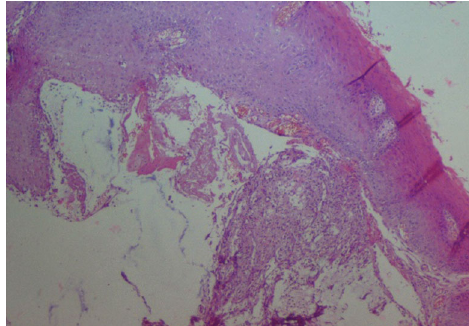
Figure 6: Perfect healing after 6 months of